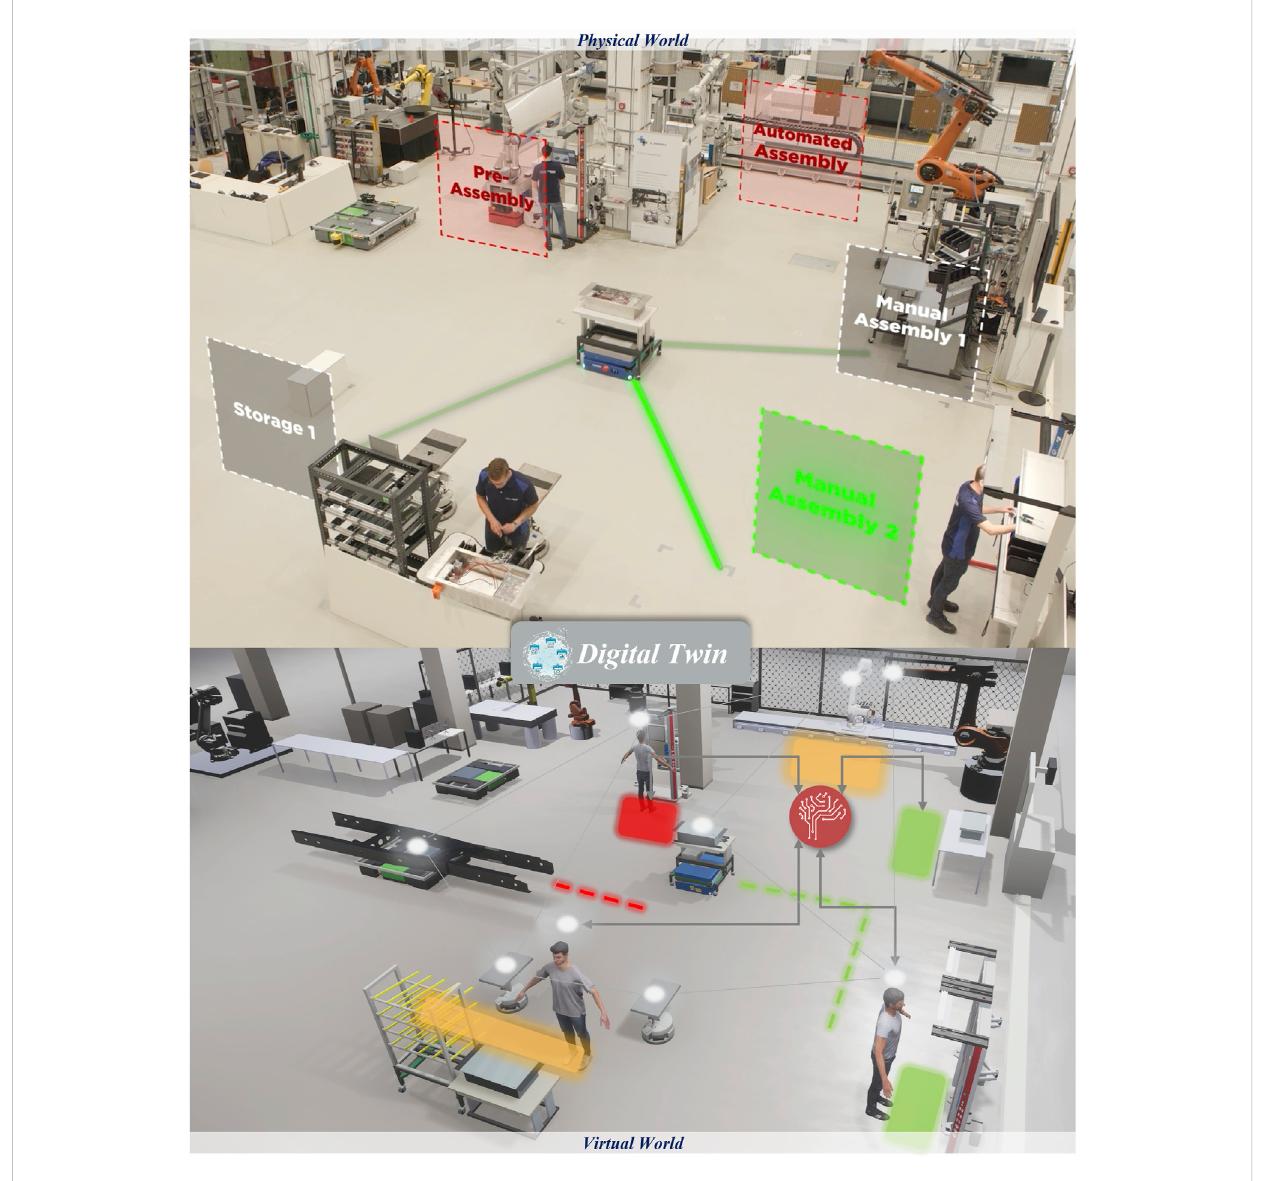
FIGURE 4 Physical and virtual representation of the line-less assembly